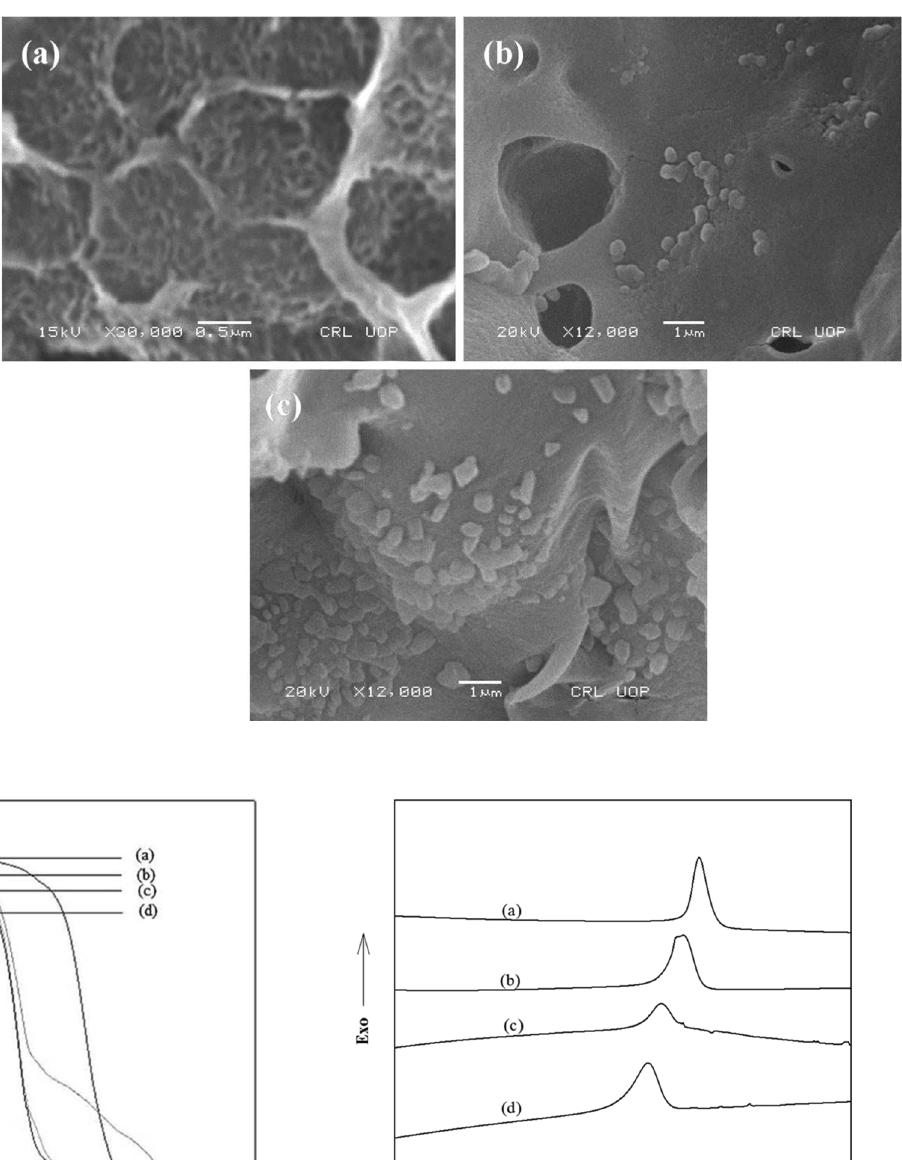
Fig. 2 SEM images of a neat